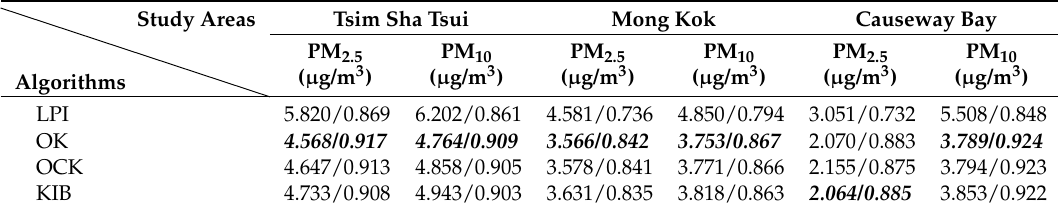
Table 3. The Comparison of the RMSE/ R 2 algorithms. The method produces the minimum RMSE and the highest R 2 and PM 10 estimation of the three study areas were italicized.